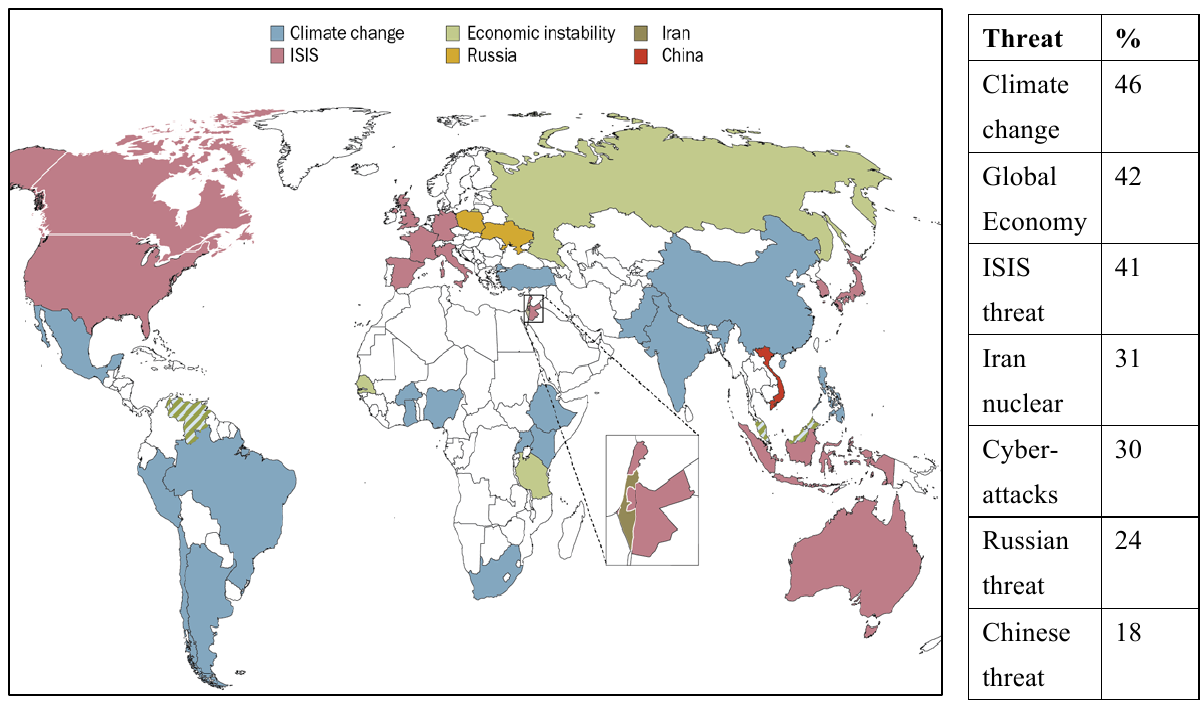
Figure 1: Priority threats, 2015: Percentages ‘very concerned’ about global problems